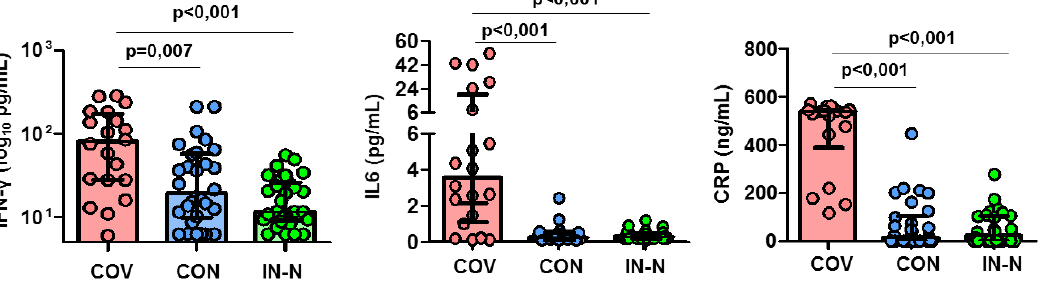
Figure 3. Plasma levels of IFN- γ, IL6 and CRP in COVID -19 patients (red, n = 20), convalescents (blue, n = 30), and infection-naïve (green, n = 30) individuals. Significant when p < 0.05.